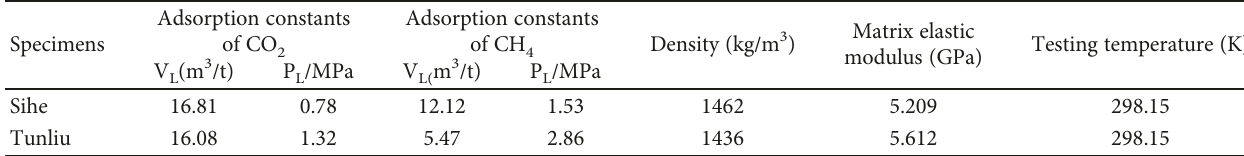
Table 2: Testing results of isothermal adsorption experiments about CO